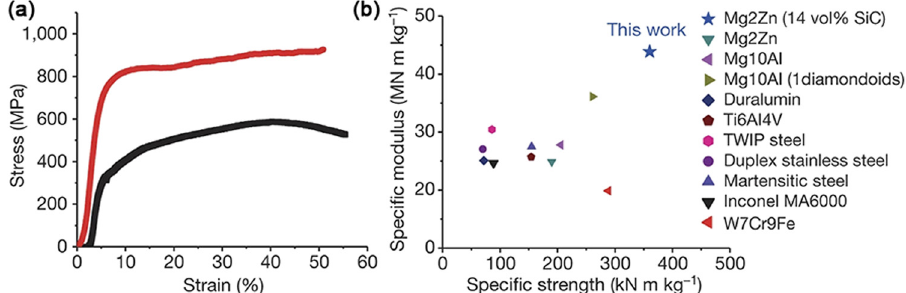
Figure 4: ( a ) Engineering stress – strain curves of Mg specimens without ( black ) and with ( red ) SiC nanoparticles. ( b ) Relationship between speci fi c modulus and speci fi c YS of Mg 2 Zn ( 14 vol% SiC ) in comparison with the microcolumn test results of other metals and alloys [ 99 ]